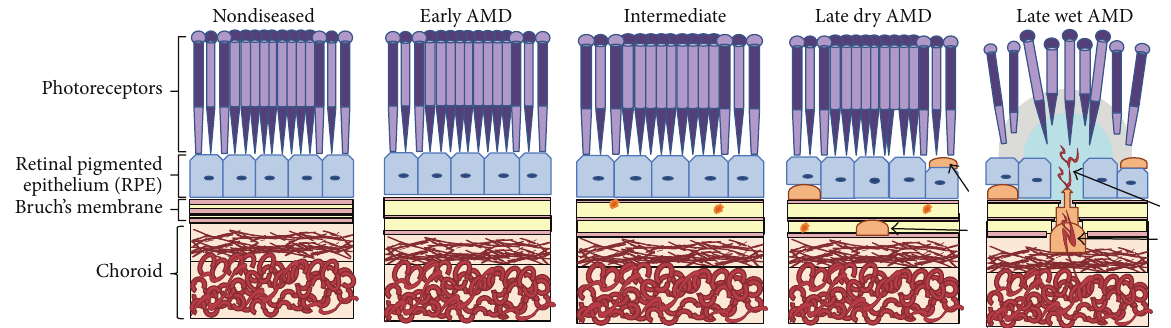
Figure 3: Stages of AMD: early AMD, intermediate AMD, late dry AMD, and late wet AMD. In the normal macula the arrangement of the cells is intact, Bruch’s membrane is the normal shape and size, and all layers and tissues function correctly. In early AMD the tissue changes begin and a thickening of Bruch’s membrane occurs. In intermediate AMD drusen (yellow circles) are clearly visible and Bruch’s membrane functionality is impaired. In late AMD drusen are larger and more prominent (arrows) and cell atrophy and structural disorder occur. In wet AMD blood vessels start to grow out from the choriocapillaris and enter the macula (arrows) through Bruch’s membrane.